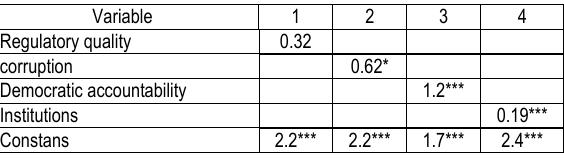
Table 3. Investment and institutional quality